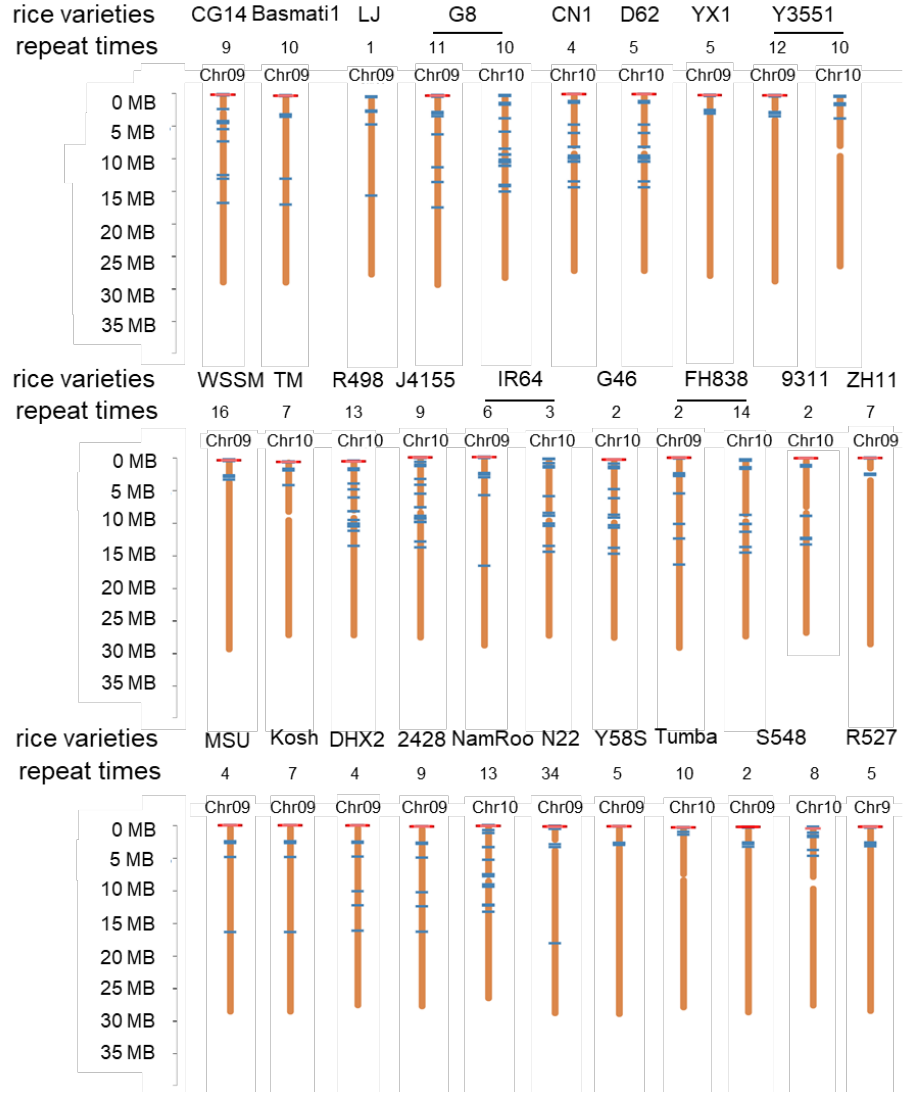
Figure 5. Homology alignment of 5.8 kb sequence from sorghum with 33 rice genomes on chromo- somes (over 90% sequence consistency).